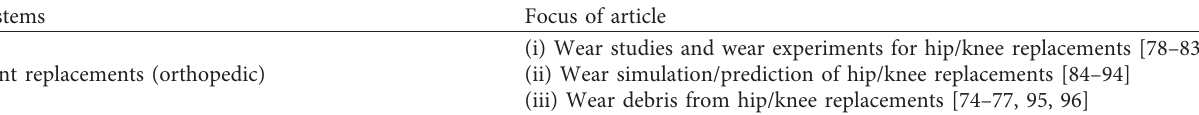
Table 2: Sample of wear studies on joint replacement (orthopedic) found in the